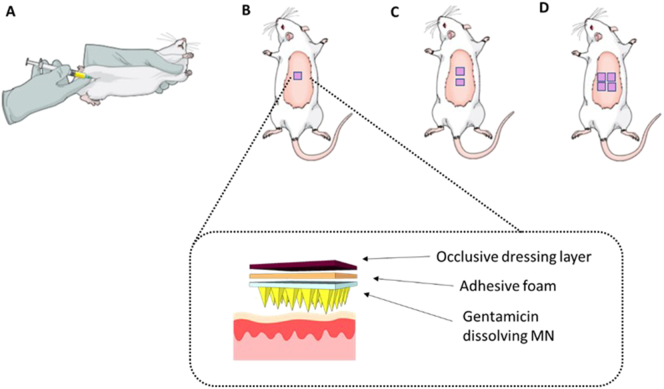
Schematic representation showing the four treatment groups investigated in the in vivo experiment. (A) IM administration of GEN, 7.5 mg/kg. Transdermal application of (B) one, (C) two and (D) four MN arrays to the hairless back of the animals and the setup used to ensure the MNs were kept in place.